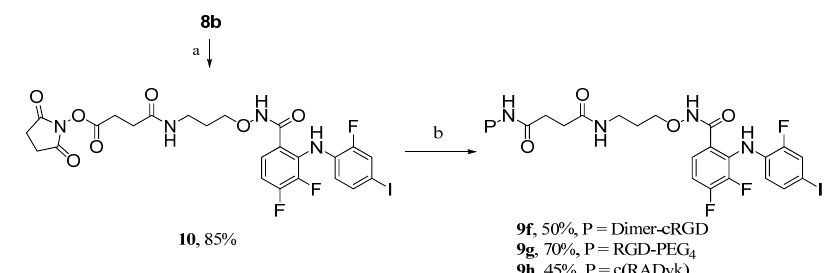
Scheme 3. Synthesis of compounds 9f (dimer-RGD conjugate), 9g (PEGylated RGD